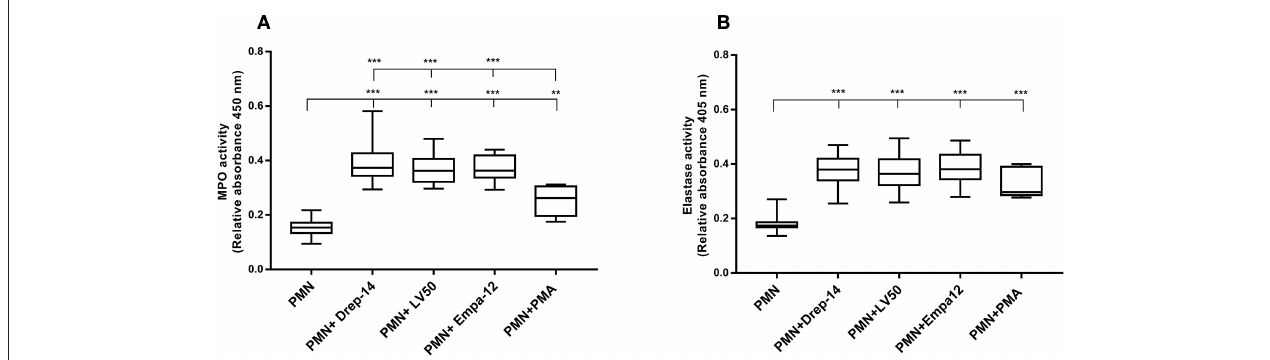
FIGURE 3 | Leishmania promastigotes stimulate the degranulation of human PMNs. PMN cultures were infected with stationary phase promastigotes of Leishmania strains or incubated with PMA (0nM & 100nM, as negative and positive control, respectively) for 18h, at 37 ◦ C in presence of 5 % CO 2 . Then, supernatants were collected and tested for the presence of enzymes released in the culture medium. (A) The enzymatic activity of MPO was quantified by an enzyme-substrate reaction using o -Dianisidine and hydrogen peroxide. The absorbance of oxidized o -Dianisidine was measured at 450nm after 10min of substrate incubation at room temperature. (B) The enzymatic activity of neutrophil elastase was determined from the same culture supernatants using a specific synthetic peptide substrate of elastase that is cleaved to colorimetric p-nitroanilide (pNA). The release of pNA was measured at 405nm after 3h of incubation at 37 ◦ C. Data are shown as the mean values from fourteen donors ± SD. Mann-Whitney test was used to compare the absorbance of (PMN) vs. each (PMN- Leishmania strain) or (PMN-PMA) supernatants, and of the infected PMNs in a pair-wise manner; ** p < 0.01 and *** p < 0.001 indicate statistically significant differences at the indicated p -values.